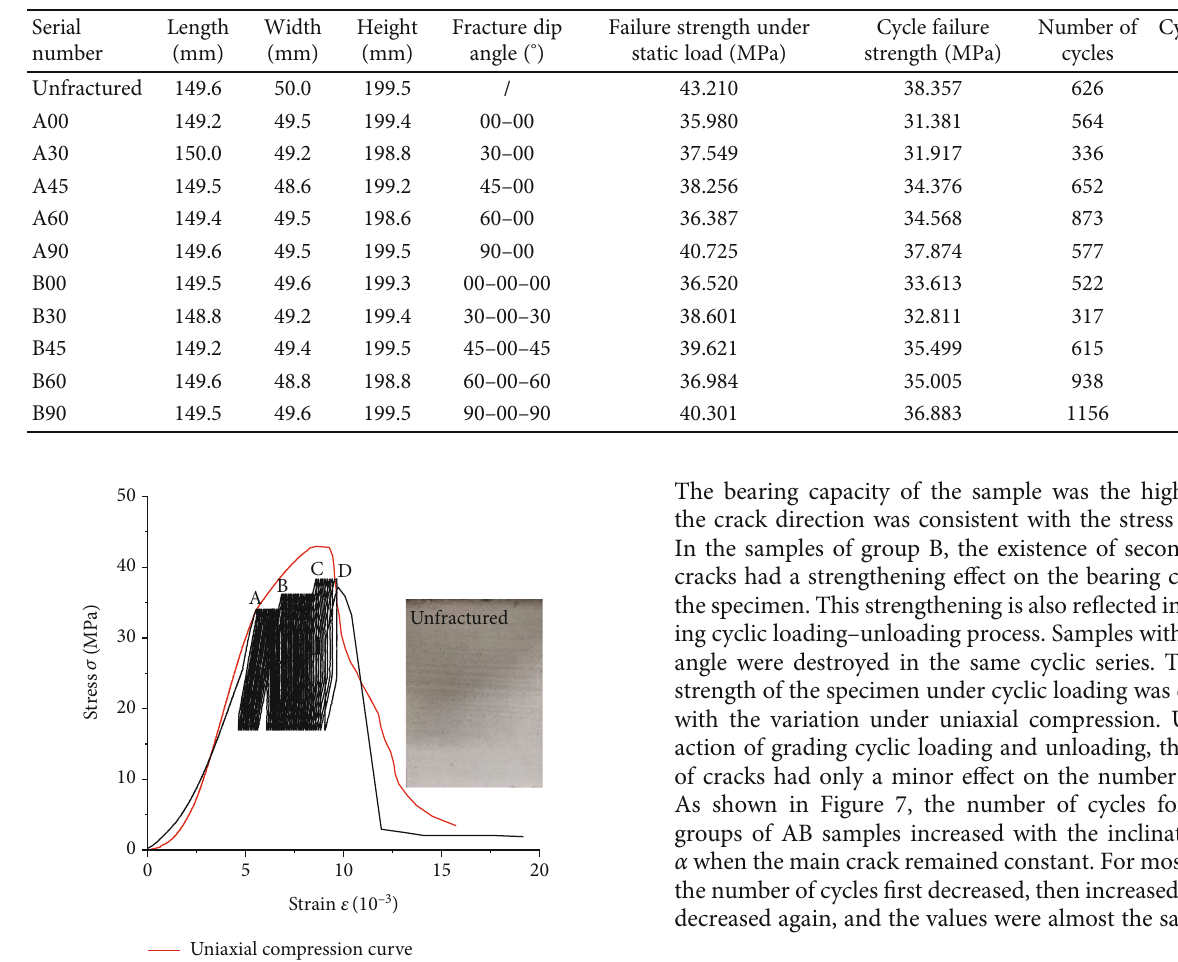
Table 1: Physical parameters of the samples.